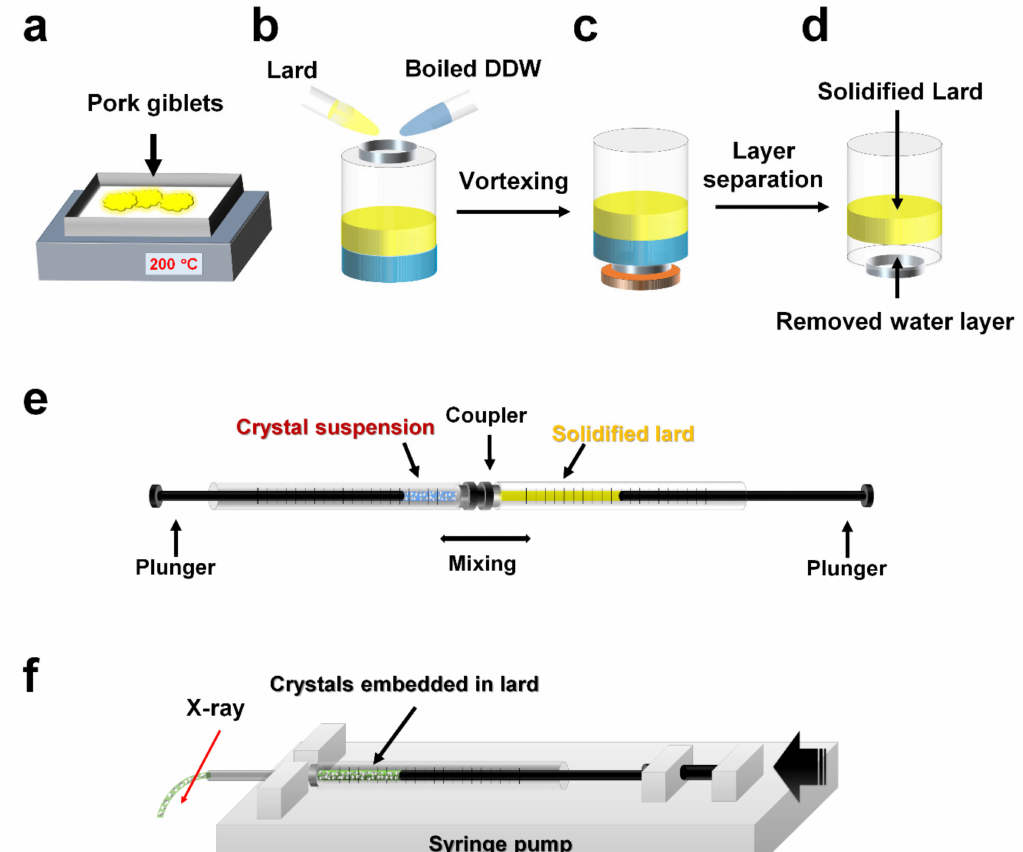
Figure 1. Schematic drawing of the preparation of lard injection matrix. ( a ) Lard extraction around pork giblets through heat treatment. ( b ) Mixing the lard extraction and boiled distilled deionized water (DDW). ( c ) Layer separation and solidification of lard by standing at room temperature. ( d ) Removing of the bottom water layer by opening the bottle cap. Boiled DDW was added again to repeat layer separation. ( e ) Mixing the crystals and lard in a dual syringe-setup. ( f ) Syringe containing the crystals embedded in lard was installed into syringe pump and delivered for serial millisecond